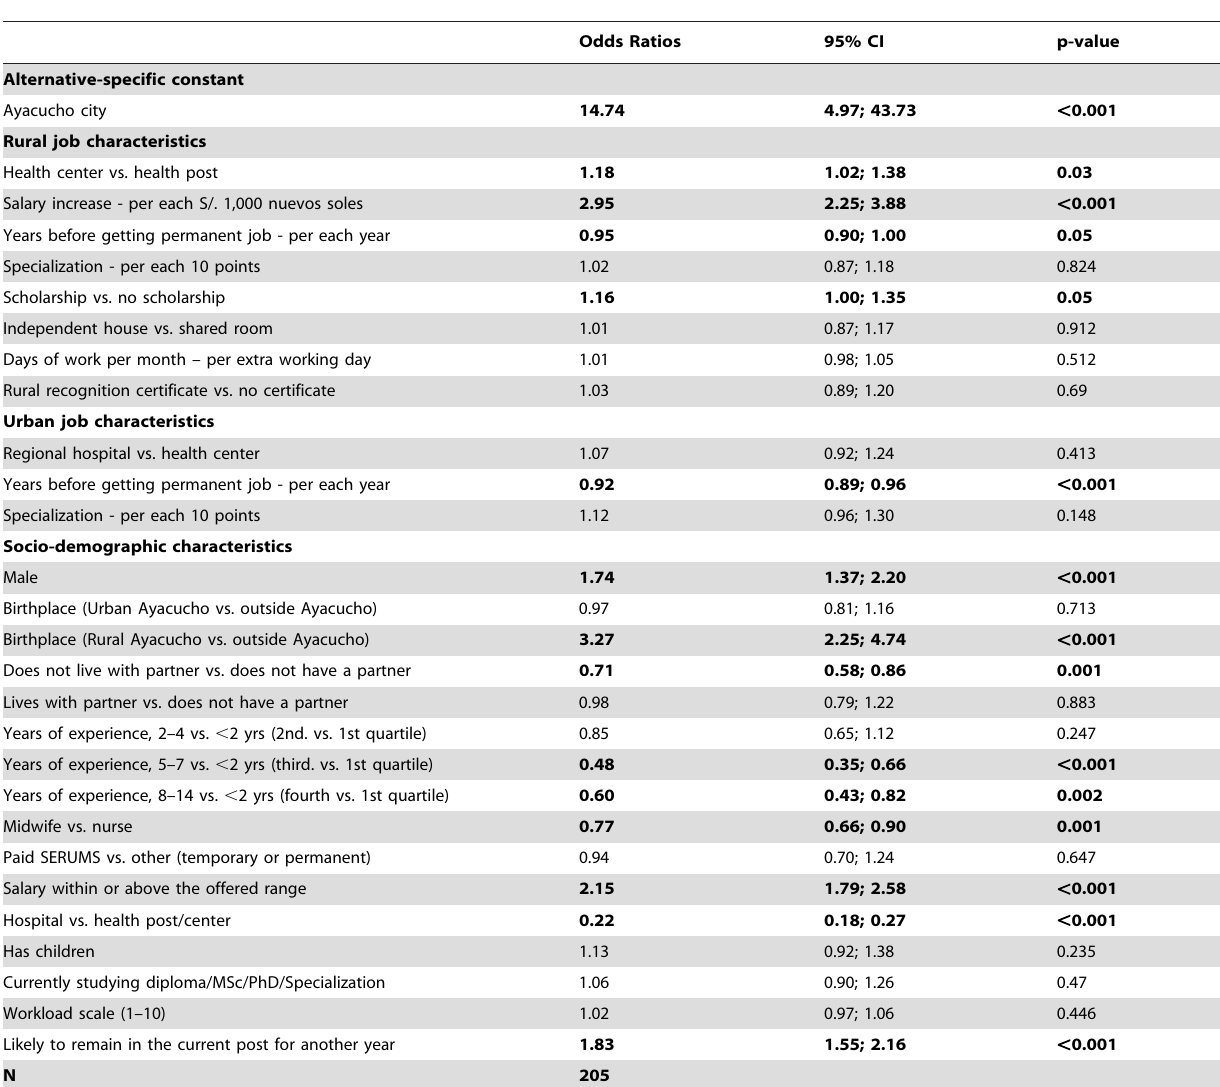
Table 4. Determinants of job preferences for nurses and midwives on a short-term contract.